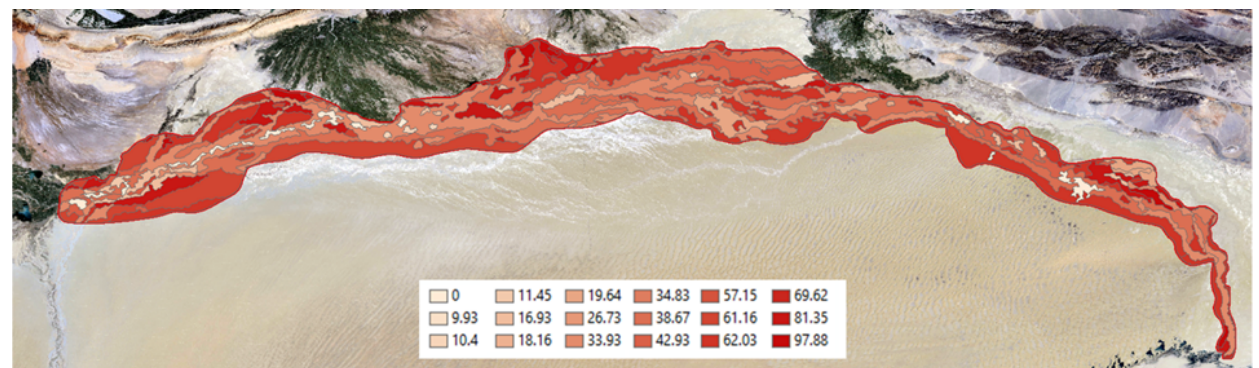
Figure 6. Distribution of the salt concentration in the soil in ECe [mScm − 1